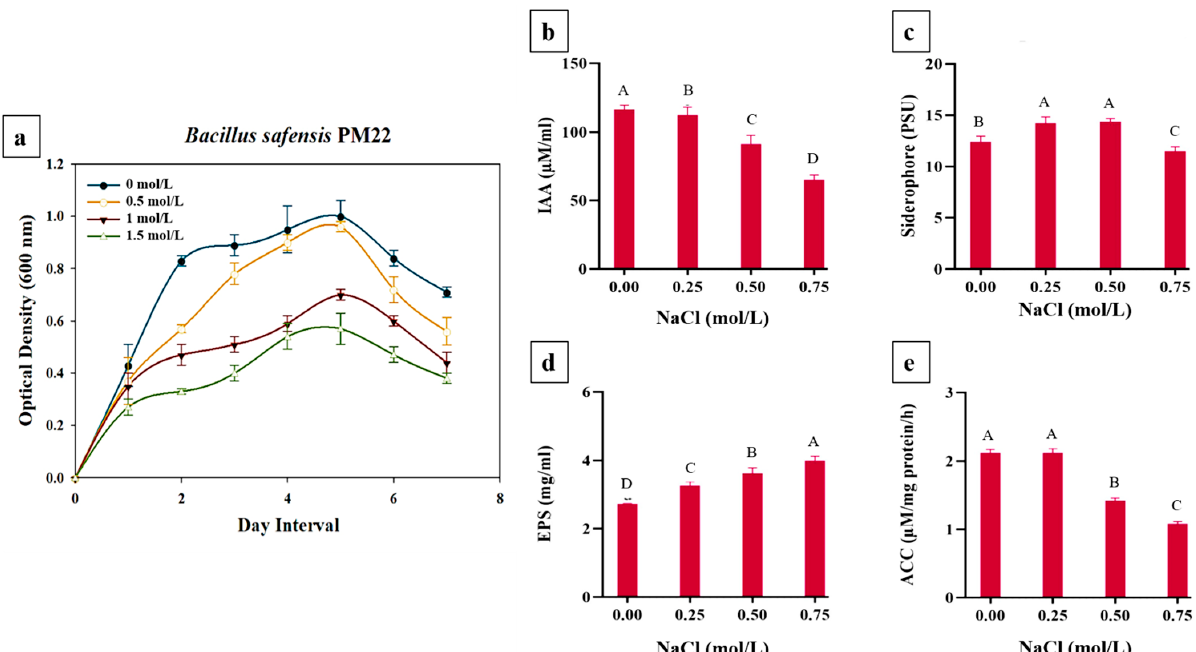
Figure 1. B. safensis PM22 growth curves at various salinity stress levels (0.0, 0.5, 1.0, and 1.5 mol/L) ( a ). Plant growth-promoting activities of B. safensis PM22 were investigated. IAA production ( b ), siderophore synthesis ( c ), EPS production ( d ), and ACC deaminase activity ( e ) were measured under various salt stress conditions. Means are used to summarize values, while bars represent standard errors. Tukey’s least significant difference (LSD) test used different alphabets to exhibit significantly different results ( p = 0.05).